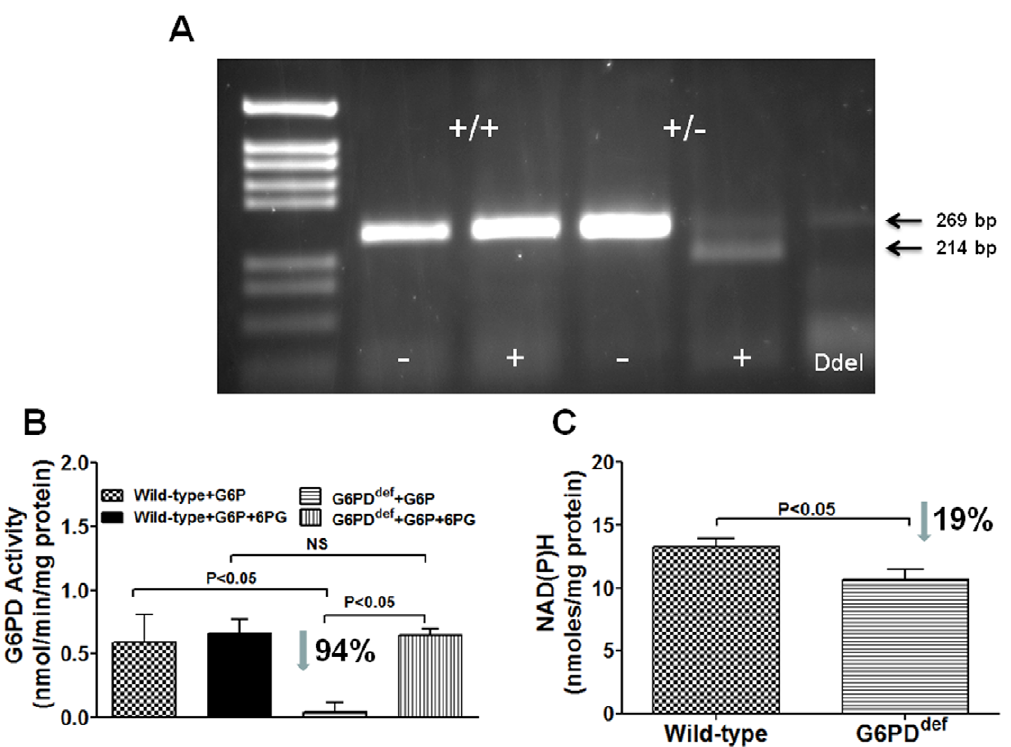
Figure 4. G6PD activity and NADPH levels in G6PD deficient mice heart. A: DNA prepared from tails snips using Viagen DirectPCR reagent. DNA amplification done using Tfi DNA polymerase (Invitrogen). Reaction products were incubated at 37C for 1 hour in the absence or presence of Dde1 before being loaded onto a 1.5% Agarose gel. Presence of the Dde1 site is indicative of the mutation in the 5 9 -UTR G6PD sequence and shifts the 269 bp reaction product down to 214 bp. Size markers are Pgem from Promeage. B; G6PD activity was determined from the rate of conversion of NADP + to NADPH in the presence of either glucose-6-phosphate (G6P) or G6P + 6-phosphogluconate (6PG) substrates. C; NADPH levels in wild-type and G6PD deficient mice hearts measured by a colorimetric method are